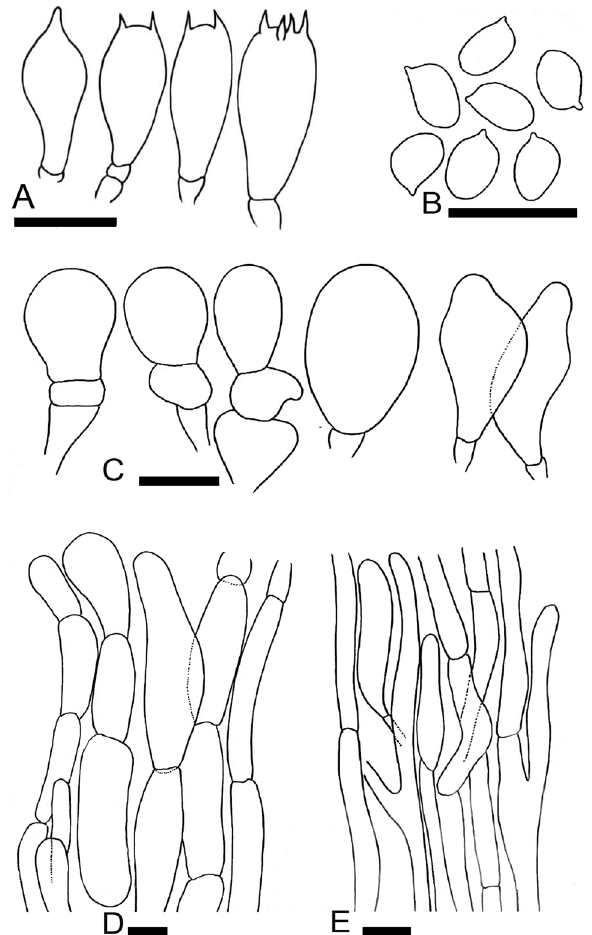
Figure 5. Micromorphological characters of A. bambusetorum. (A–E) CM242 ( Holotype ); (A) Basidia, (B) Basidiospores, (C) Cheilocystidia, ( D) Pileipellis hyphae, (E) Stipitipellis hyphae. Bars = 10 µm. Drawings by Dr. Hira